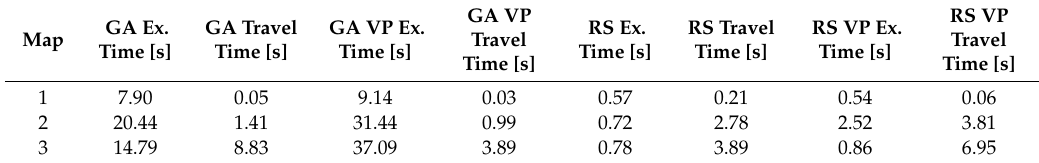
Table 5. Standard deviation of times of algorithm execution and travel.